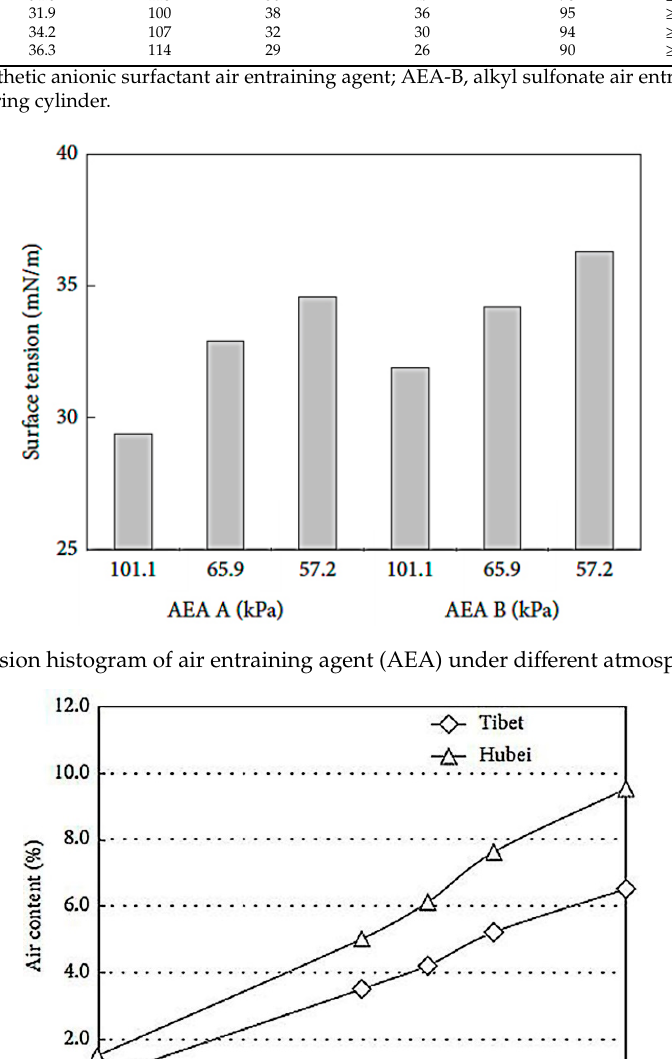
Table 2. Foaming ability of air entraining agent (AEA) under di ff erent atmospheric pressures (AP).